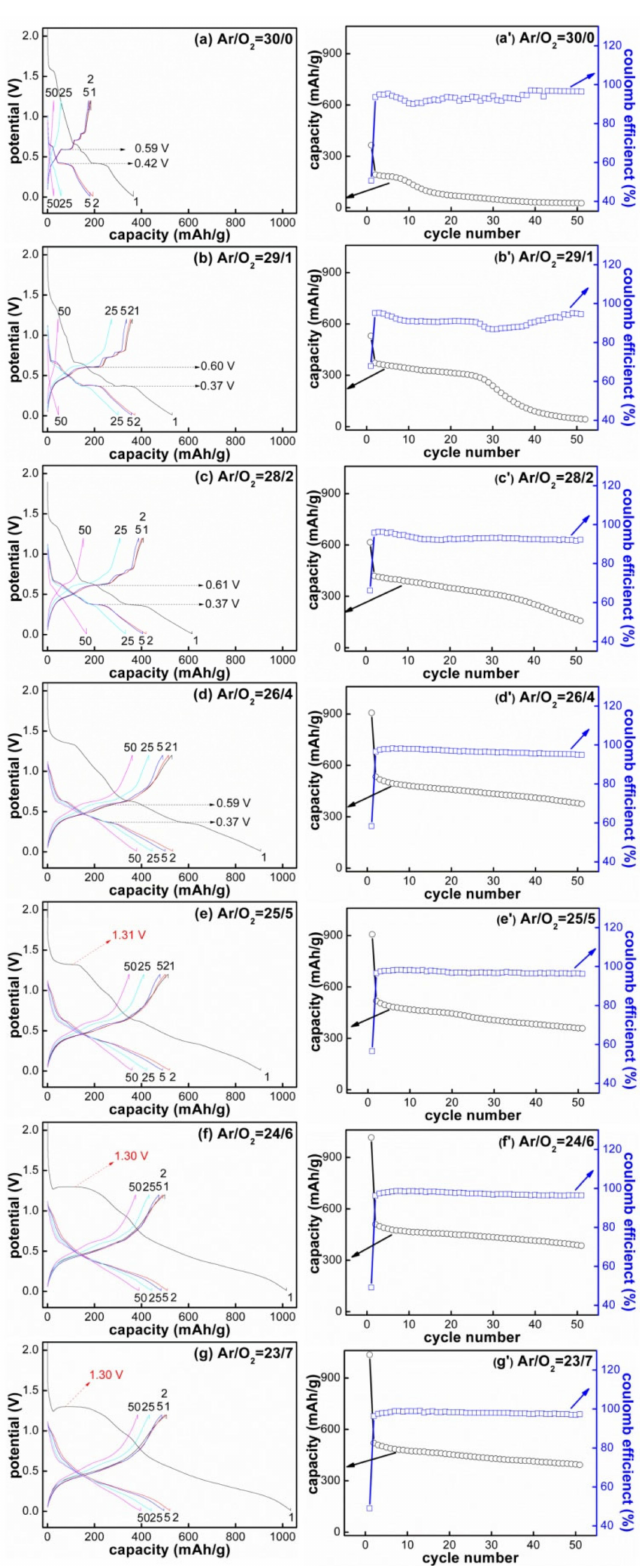
Figure 6. Cycling performance of the SnO x films deposited with different Ar/O 2 flow ratios: ( a , a’ ) 30/0, ( b , b’ ) 29/1, ( c , c’ ) 28/2, ( d , d’ ) 26/4, ( e , e’ ) 25/5, ( f , f’ ) 24/6 and ( g , g’ )